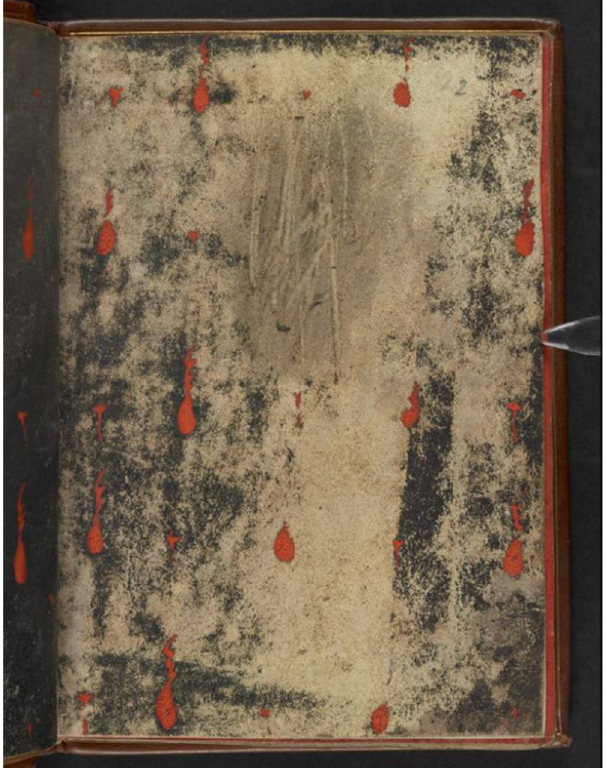
Figure 6. It is perhaps possible to trace the intimate and emotive use of the book in its pages. One page has clearly been rubbed or kissed or perhaps erased by a post-reformation owner trying to obliterate the animated pages of the living book. MS Egerton 1821, fol. 2r. British Library, London.